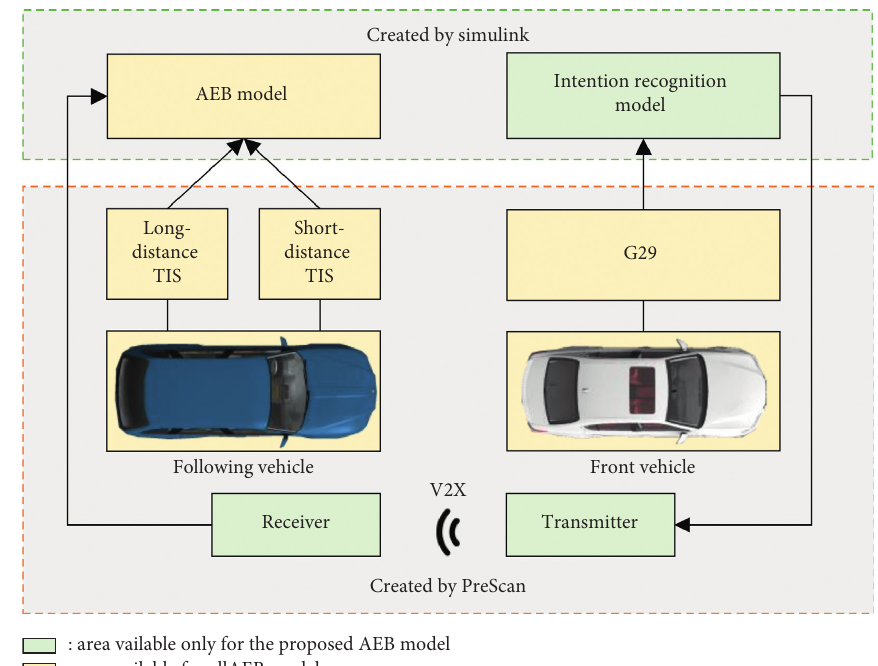
Figure 5: Schematic diagram of AEB model joint simulation.